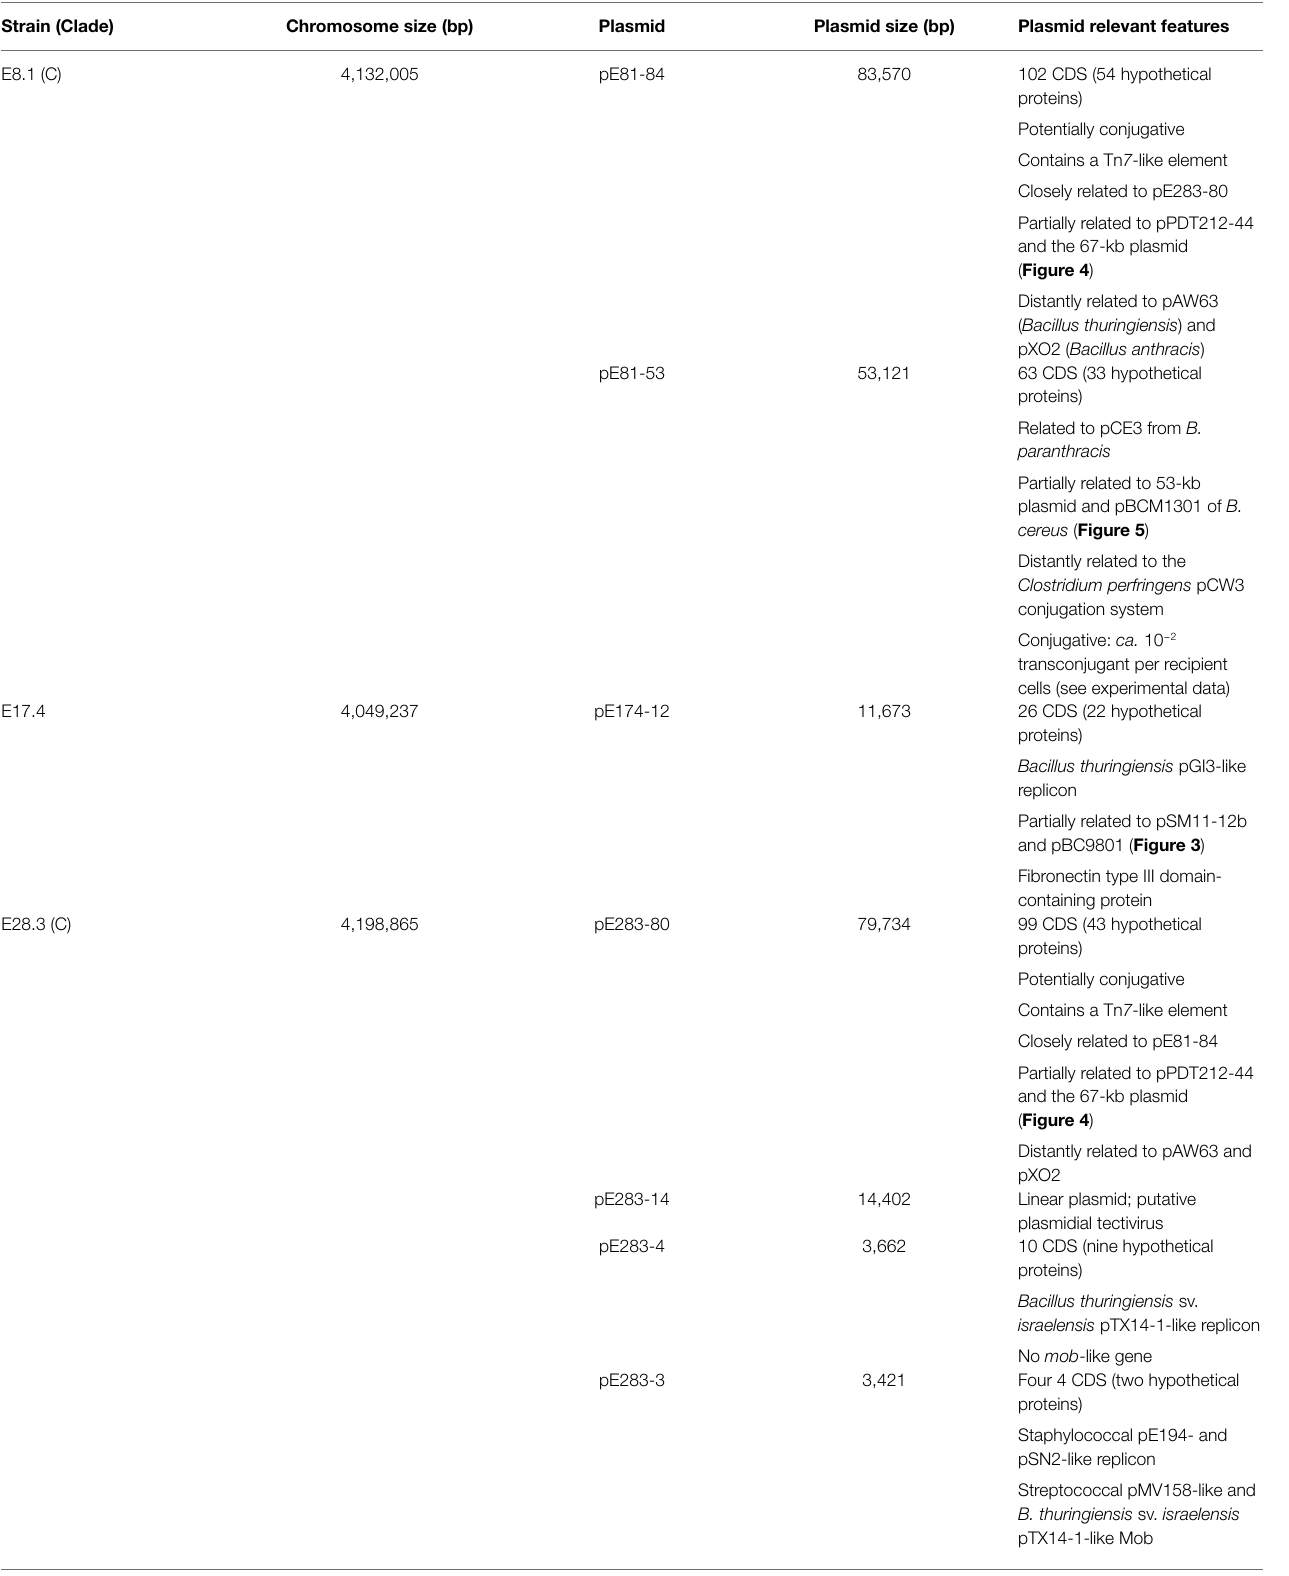
TABLE 2 | Genomic features of the six sequenced B. cytotoxicus strains. Strain (Clade) Chromosome size